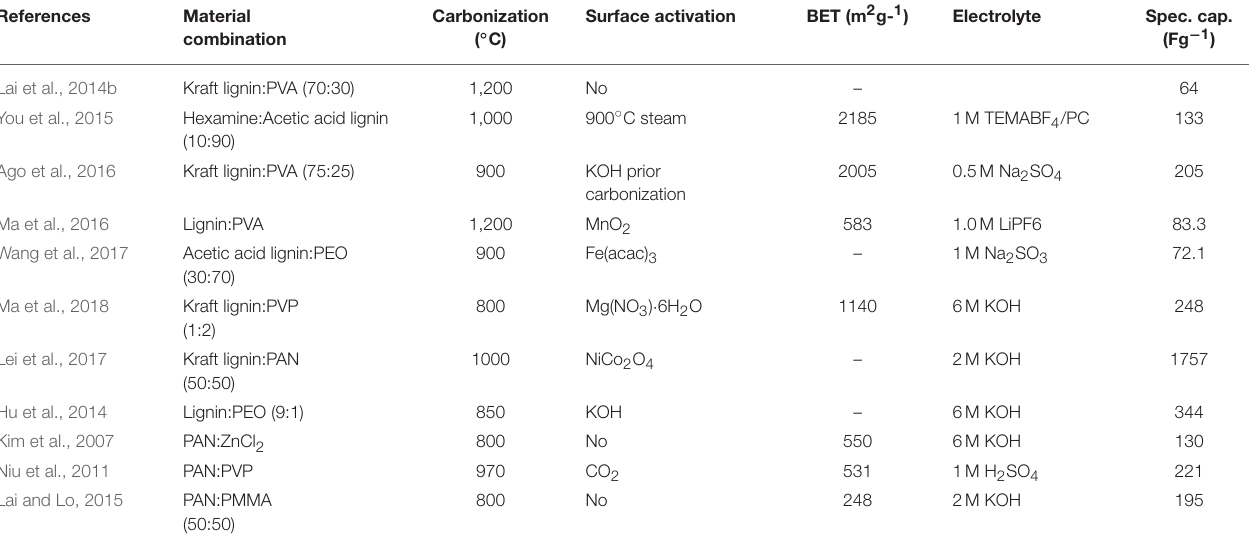
TABLE 1 | Electrospun carbon fibers tested in energy storage